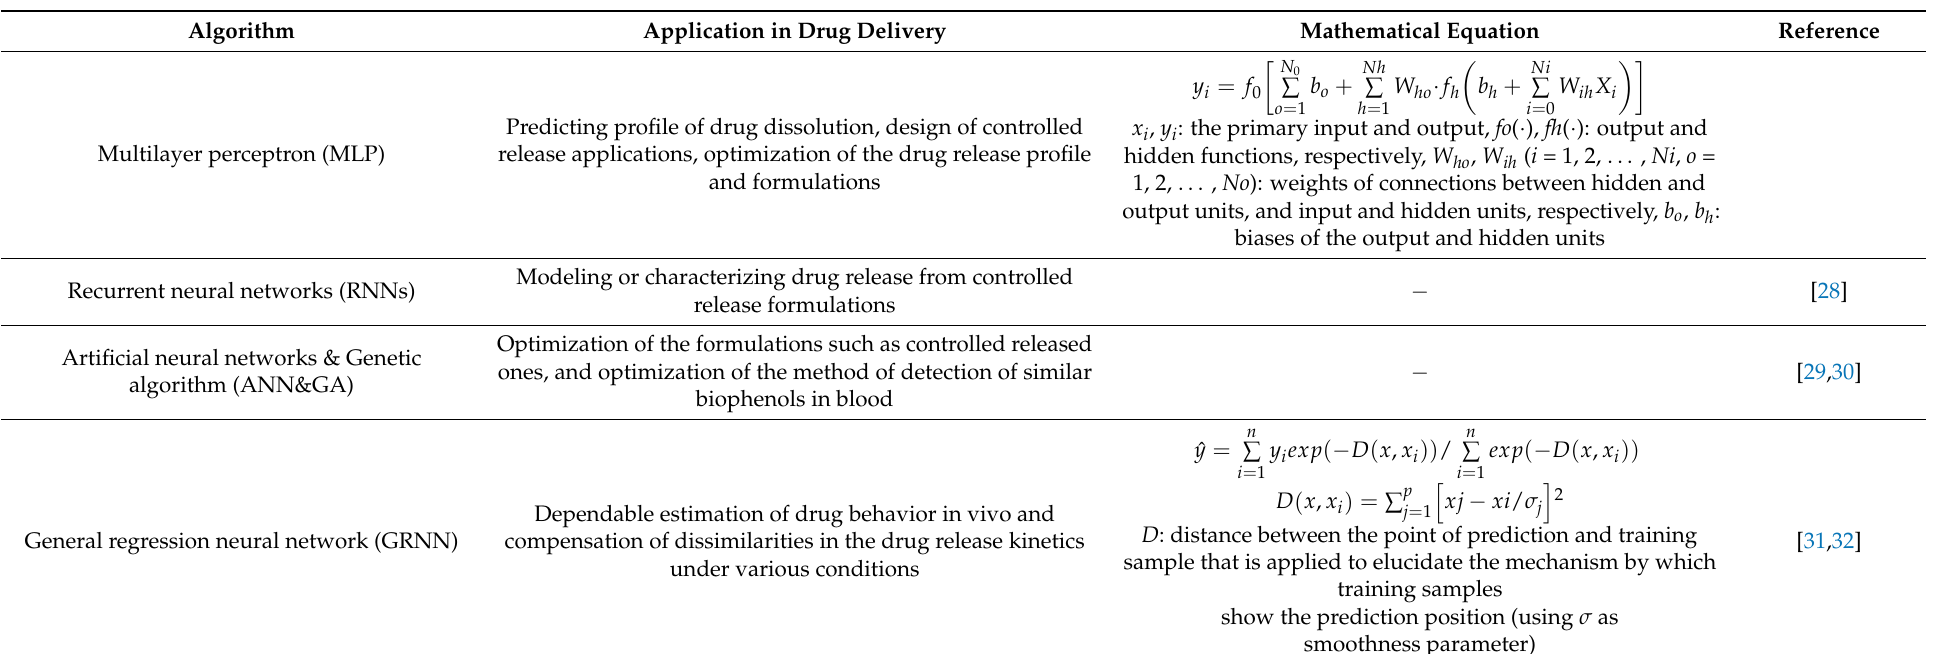
Table 1. AI algorithms that are used in drug delivery research and their